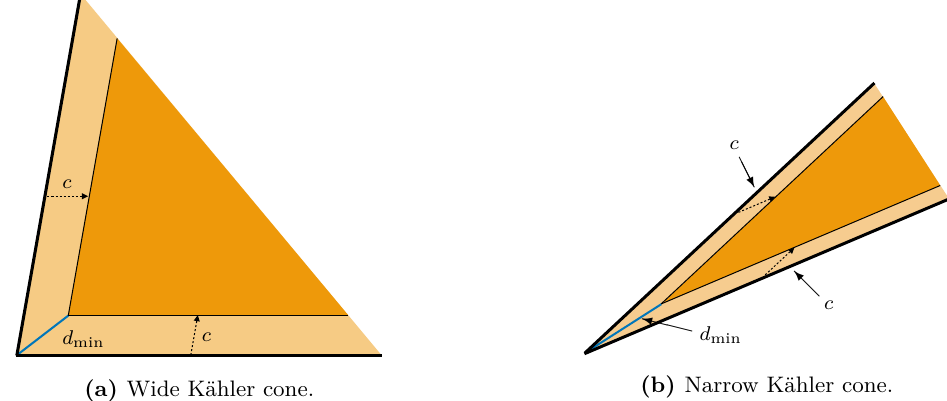
Figure 1. Kähler and stretched Kähler cones K and e K for a two-dimensional setting. In figure 1a a wide cone is shown, while in figure 1b we have displayed a narrow Kähler cone. The darker shaded regions are the stretched Kähler cones with parameter c , and we have included the minimal distance d between the tip of the cone and the stretched cone for both min